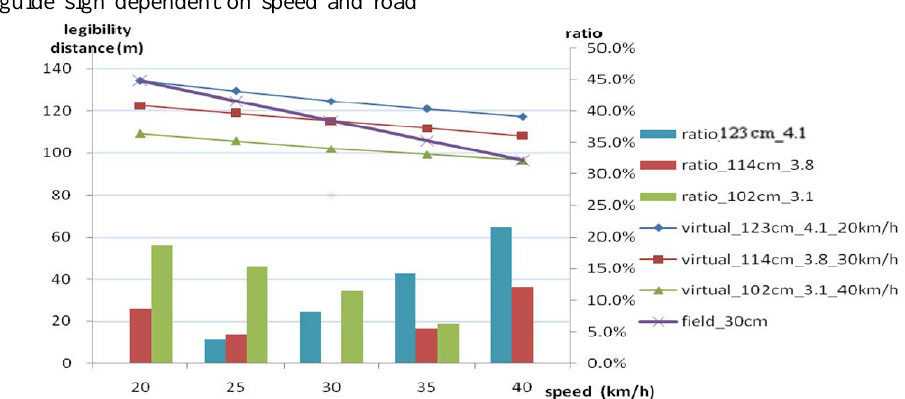
Fig.11. Comparative analysis legibility distance in field and virtual scenarios after